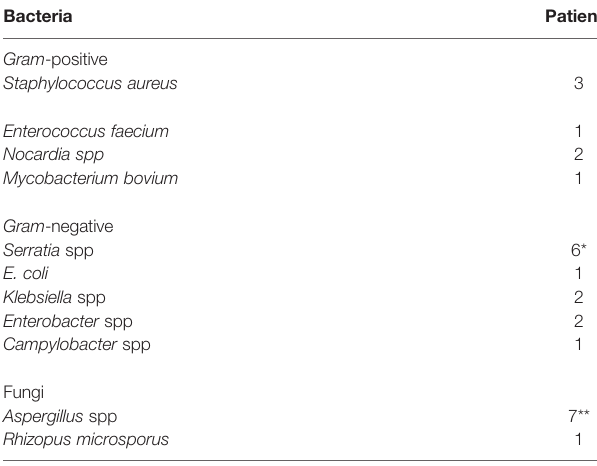
TABLE 2 | Pathogens isolated in 19 patients with onset of chronic granulomatous disease within the fi rst six weeks of life. Bacteria Patients Gram -positive Staphylococcus aureus 3 Enterococcus faecium 1 Nocardia spp 2 Mycobacterium bovium 1 Gram -negative Serratia spp 6* E. coli 1 Klebsiella spp 2 Enterobacter spp 2 Campylobacter spp 1 Fungi Aspergillus spp 7** Rhizopus microsporus 1 *5 patients with Serratia marcescens. **4 patients with A. fumigatus; 3 additional patients suffered from probable invasive aspergillosis (galactomannan positive, pulmonary in fi